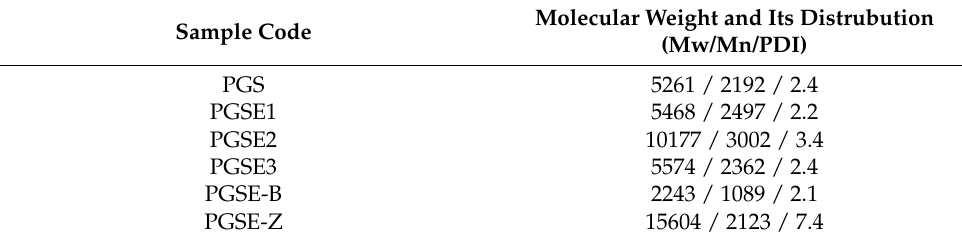
Table 2. Molecular weight of the